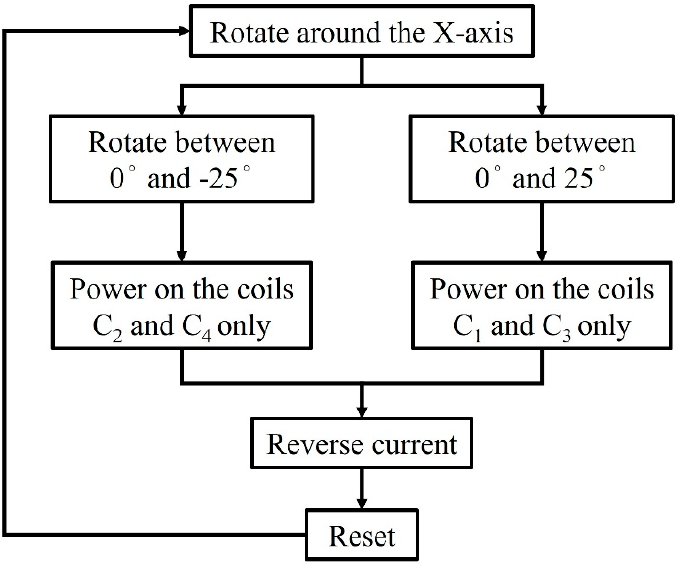
Figure 6. Flowchart to actuate proposed 3-DOF spherical motor for rotating around the X -axis.